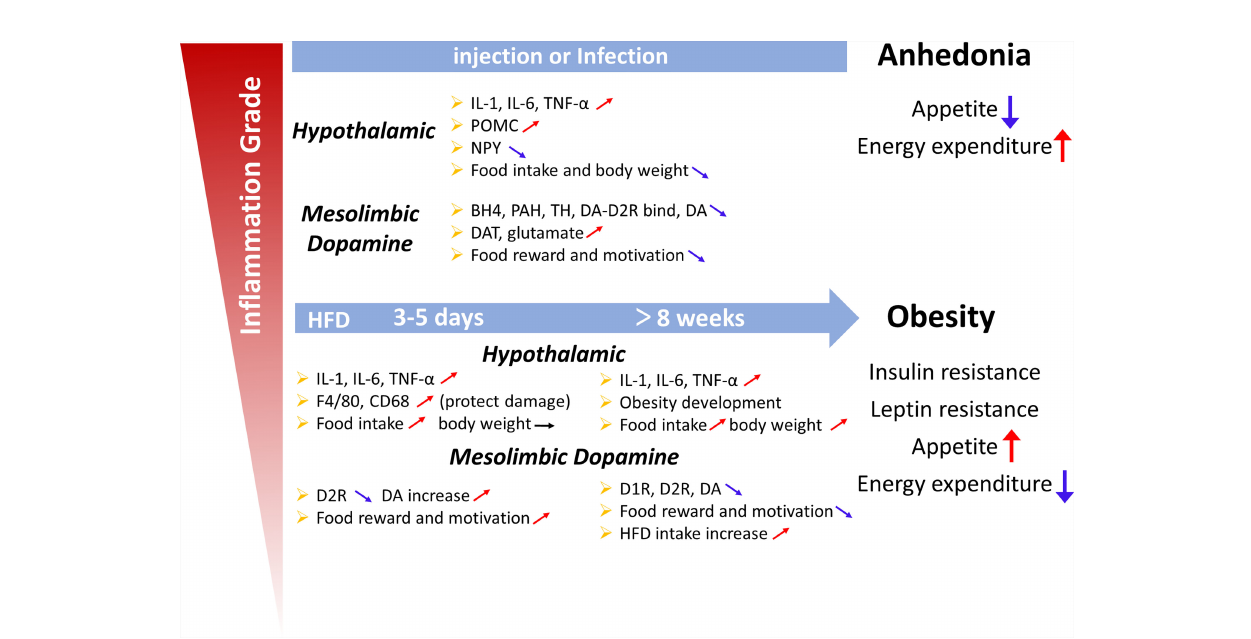
FIGURE 3 | Summary diagram illustrating the links between in fl ammation in the hypothalamus and midbrain dopamine system with the deregulation of appetite. Upper panel: Lipopolysaccharide or cytokines injections, illnesses such as cancer, or infections induce high-grade in fl ammation. An acute increase in the local production of cytokines and chemokines is observed in the hypothalamic and midbrain dopamine systems. Cytokines, including IL-1, IL-6 and TNF- a , change the levels of neuropeptides (POMC, NPY and dopamine) involved in the hypothalamic and dopamine systems, which are associated with appetite and weight loss (the sickness behavior associated with a high-intensity infection). Lower panel: Short (3 days) or chronic (>8 weeks) HFD consumption is associated with low-grade in fl ammation. The increase in cytokine levels induced by a HFD also changes the levels of neuropeptides involved in the hypothalamic and dopamine systems, which appears to be associated with overeating and body weight gain and the development of obesity, leptin resistance and insulin resistance, potentially increasing appetite, and weight. However, in the fi rst 3 days, the weight was not changed, which may protect organs from HFD-induced